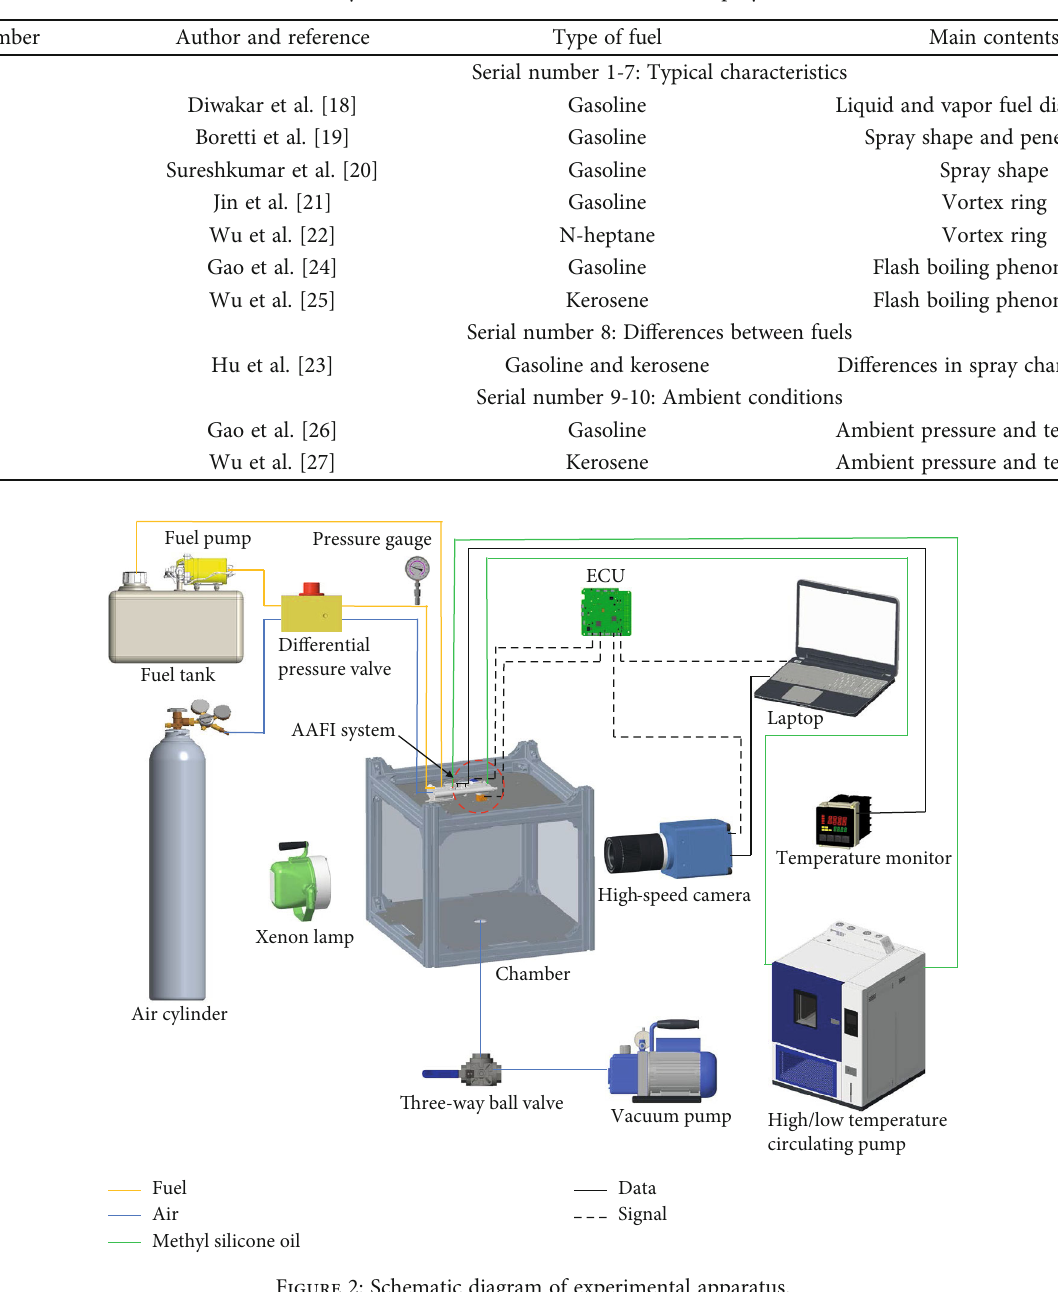
Table 1: A summary of the literature related to air-assisted spray characteristics.